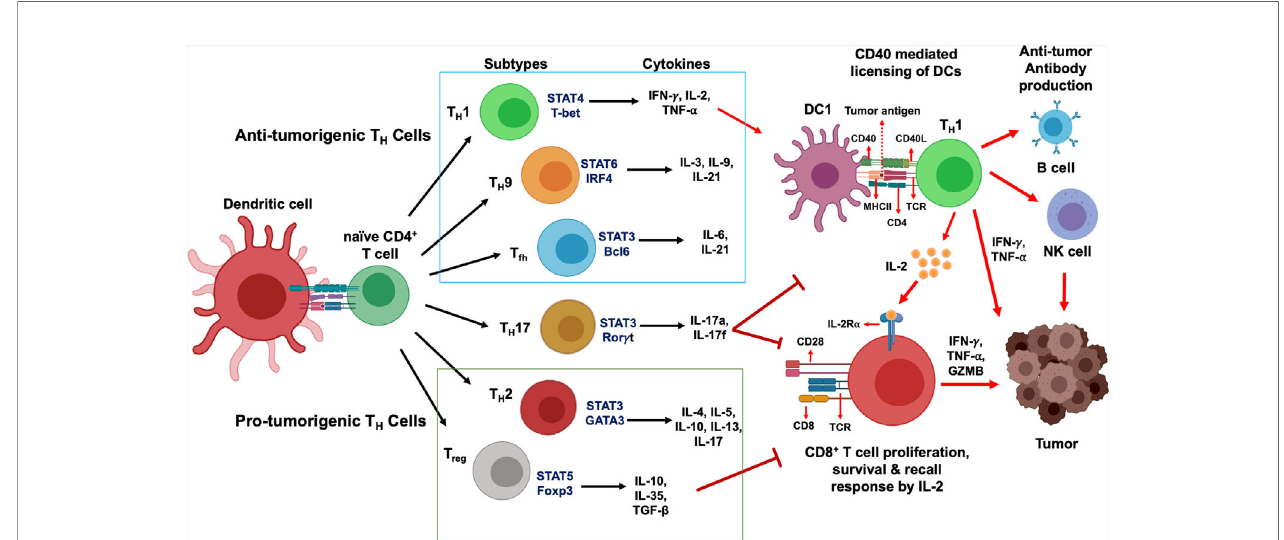
FIGURE 1 | CD4+ T cells development and their functional subsets in immunity. T cell receptor (TCR) signaling activation, co-stimulation and presence of speci fi c cytokines milieu have been shown to stimulate naïve CD4 + T cells polarization and their differentiation into T H 1, T H 2, T H 9, T H 17, T fh and T reg cell subtypes. While T H 1, T H 9 and T fh cells ( green box ) stimulate anti-tumor immune response, T H 2 and T reg cells ( red box) induce immunosuppressive protumorigenic response and a dual role of T H 17 cells contribute to the functional complexity of this network. Primary STAT signaling pathways and major transcription factors regulating CD4 + T cell subtype polarization and key effector cytokines secreted from each Th cell subtypes are depicted. Dendritic cells present tumor antigenic peptides to T H 1 cells via MHC class II molecule, leading to T H 1 immune response activation. IFN- g and TNF- a secreted from activated T H 1 cells directly act on tumor cells and induce apoptosis, senescence, and proliferation arrest. In addition, T H 1 cells can upregulate NK cells and B cells activation to further strengthen anti-tumor immune responses. Activated T H 1 cells secrete IL-2 which mediates direct activation of CD8 + T cells expressing IL-2R a and their proliferation and survival. In contrast, T reg cells and T H 17 cells are known to exhibit an immunosuppressive microenvironment that promotes tumor